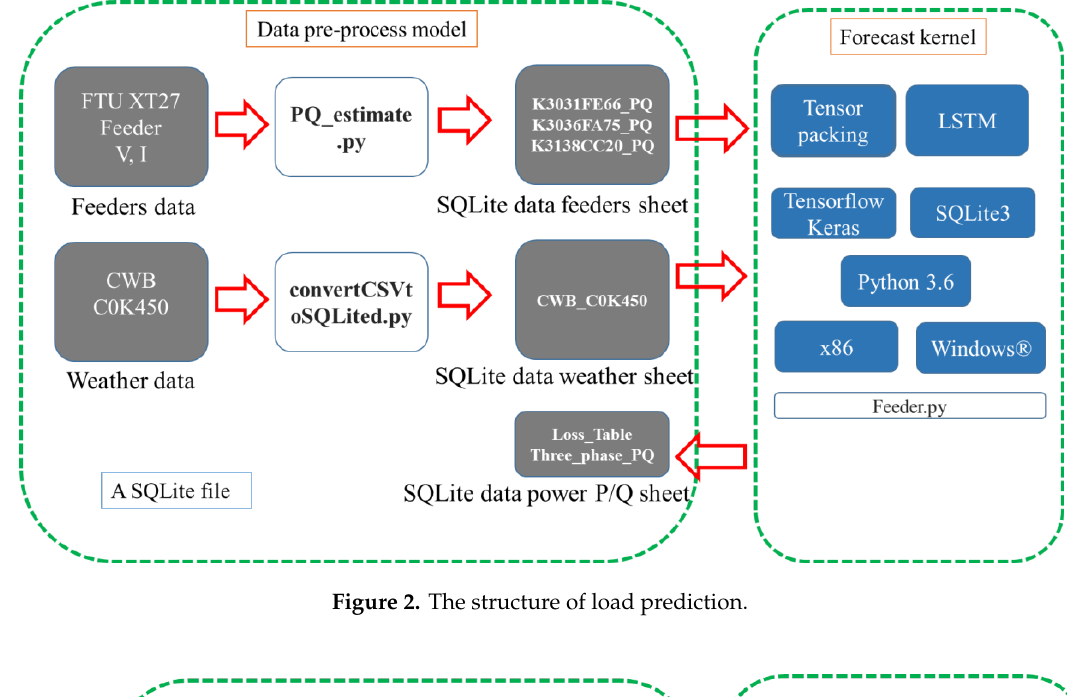
Figure 2. The structure of load prediction.